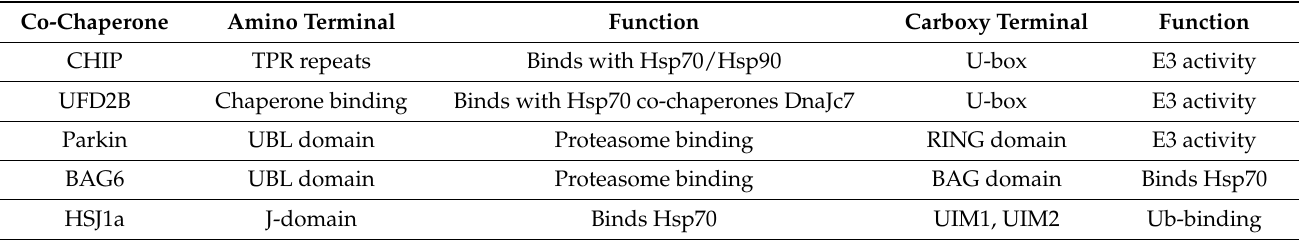
Table 1. N-terminal and C-terminal domains of co-chaperones